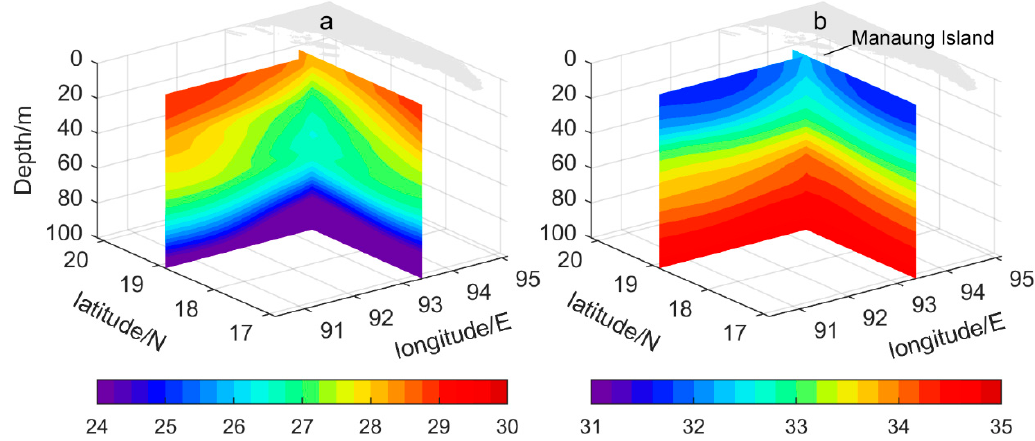
Figure 3. The climatologically sectional distributions of ( a ) temperature (unit: °C ) and ( b ) salinity (unit: psu) of two sections in spring. The locations of the two sections are shown in Figure 2c. Seasonal evolution for the coastal upwelling o ff Manaung Island is further explored using WOA18 climatologically monthly temperature and salinity data (Figure 4). In February, a high-salinity zone starts to form in the surface o ff the coasts of Manaung Island, while the low-temperature signal is not significant. This is mainly because the southward flowing low-temperature water from the northern Bay along the coasts during that period [46] covers the upwelled cold water from subsurface. In fact, both the low-temperature and high-salinity signals of the upwelling are clearly presented in the subsurface layers between 40 and 80 m around the coastal areas of Manaung Island in February (Figure 5). In March, the extent of low-temperature and high-salinity water is the largest, indicating that the coastal upwelling reaches its peak in this month. Subsequently, the extent of low-temperature and high-salinity water significantly shrinks in April and disappears in May. Thus, April and May are periods for the decay and dissipation of the coastal upwelling of Manaung Island.